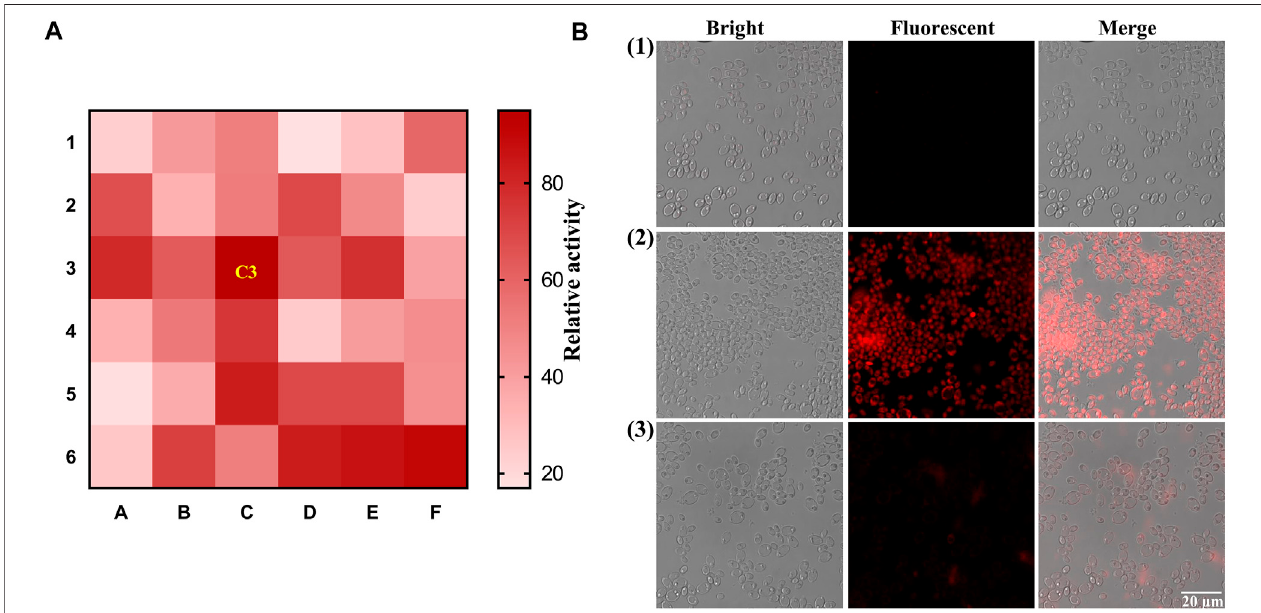
FIGURE 3 | Visual identi fi cation of intestinal fungi with strong activity of β -Glc. (A) The heat-map for the screening of intestinal fungal β -Glc. (B) Fluorescence imaging of Pichia terricola M2 stained by DXM-Glc using Confocal laser scanning microscope. (1) Blank group. (2) Pichia terricola M2 stained by DXM-Glc . (3) Pichia terricola M2 stained by DXM-Glc in the presence of